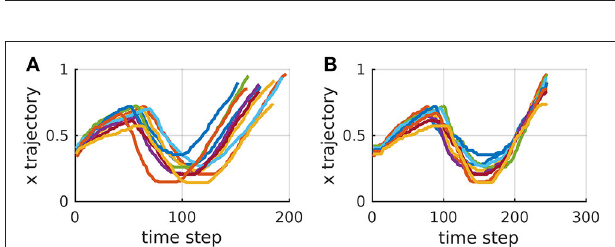
FIGURE 3 | x trajectories of corresponding strokes of multiple instances of a Japanese character. (A) Before time alignment. (B) After time alignment using DTW and our extension to deal with multiple